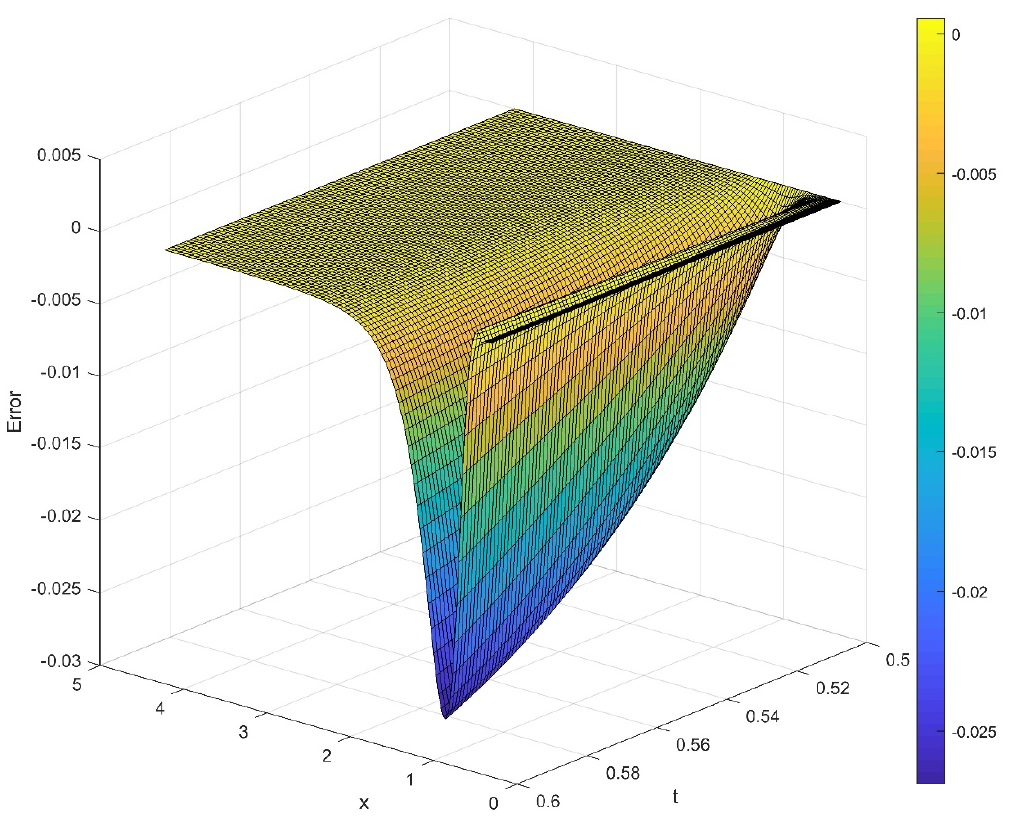
Figure 17. The difference between the analytical solution and the CLL method for h = 1.0 · 10 − 3 as a function of space and time for Experiment 5.